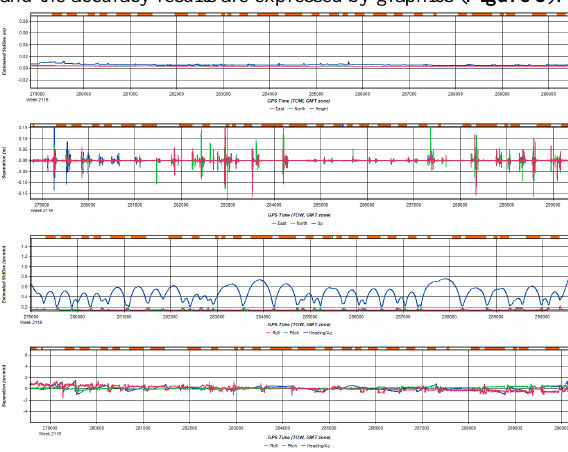
Figure 8 . Post-processing results with Loosely coupled method, Forward – Reverse combined and smoothed solutions